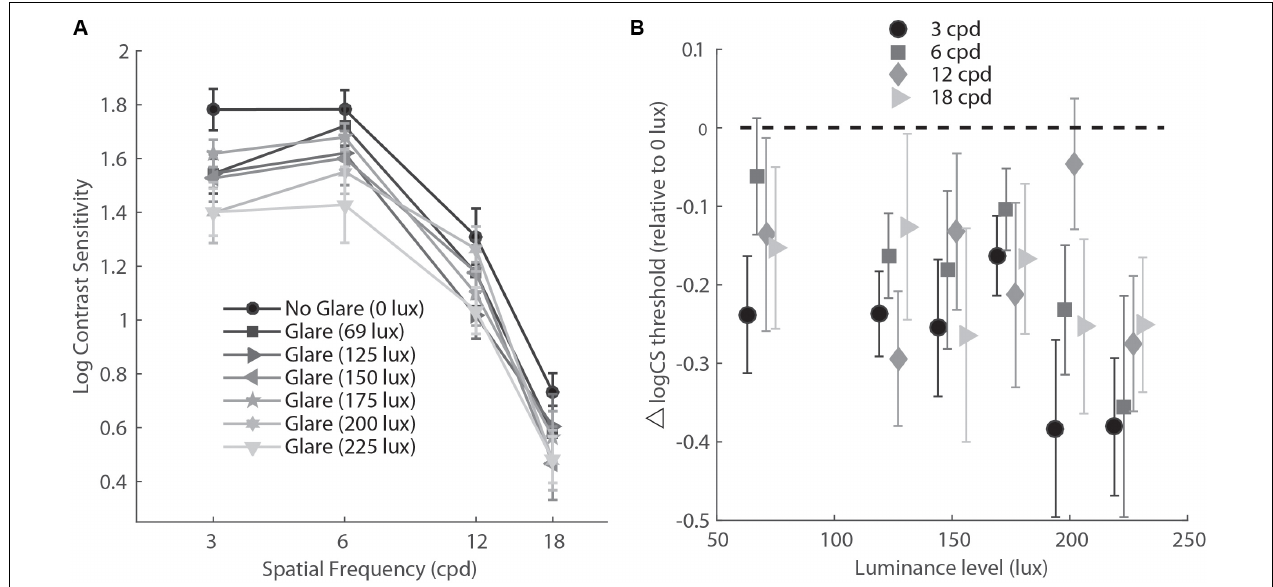
FIGURE 4 | (A) Contrast sensitivity function in mesopic light condition for six levels of glare (variable lux) and no glare (0 lux). (B) Data re-plotted to show the difference between CS measurements at various levels of glare (abscissa) compared to no glare (glare – no glare condition), for each level of spatial frequency. cpd, cycles per